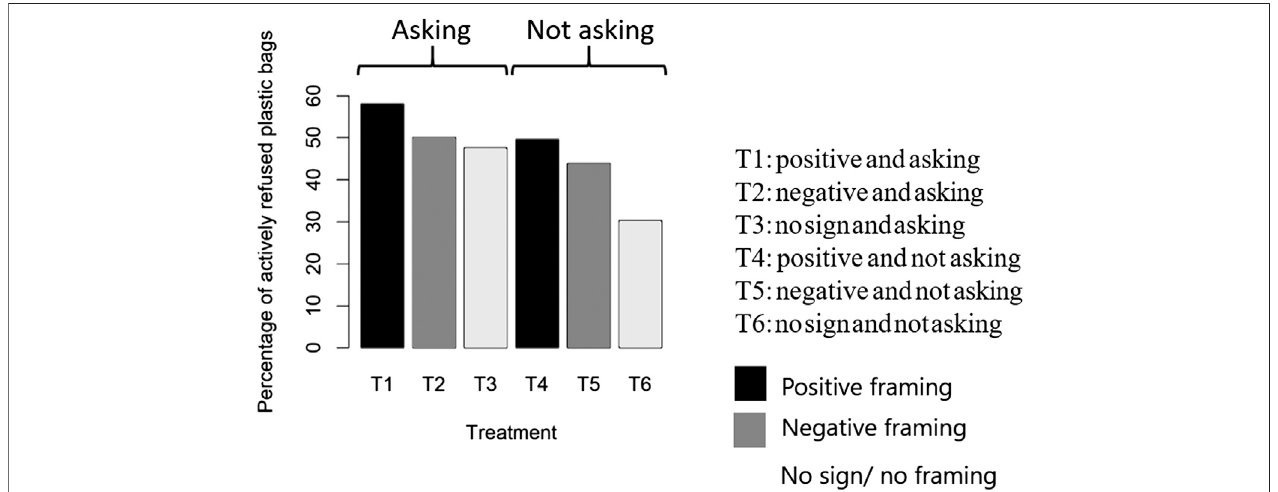
FIGURE 3 | Percentage of actively refused plastic bags per treatment including the treatment description.